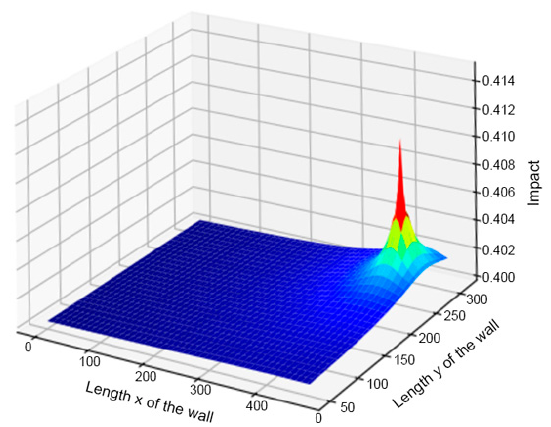
season in 2013: 24 February, 29 June, 29 July and 28 October.